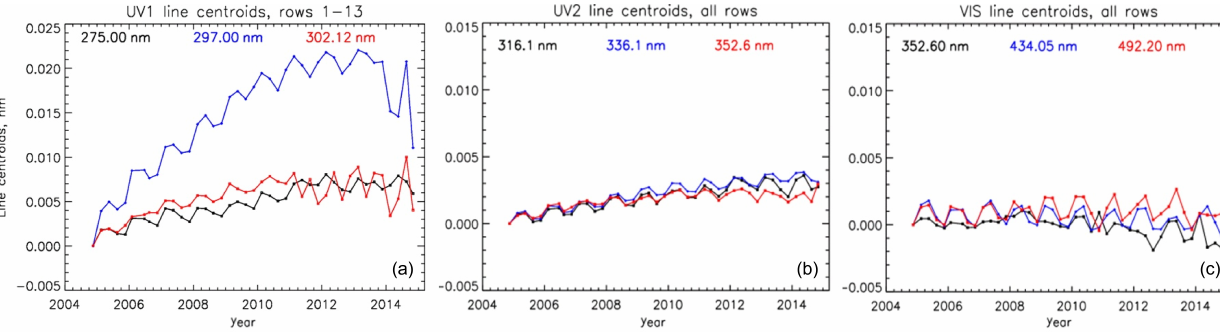
Figure 34. Changes in the line centroids of prominent absorption blends in the solar irradiances observed in UV1 (a) , UV2 (b) and VIS (c) .